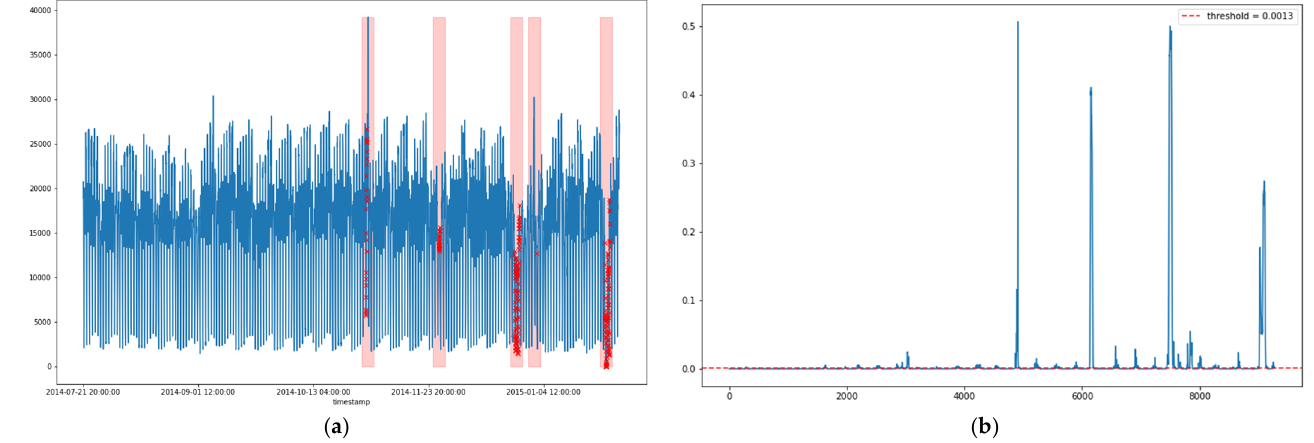
Figure 7. Anomaly detection by our SSL method for NAB NYC taxi dataset. ( a ) Anomaly points with original NAB NYC taxi dataset; ( b ) anomaly score with threshold.